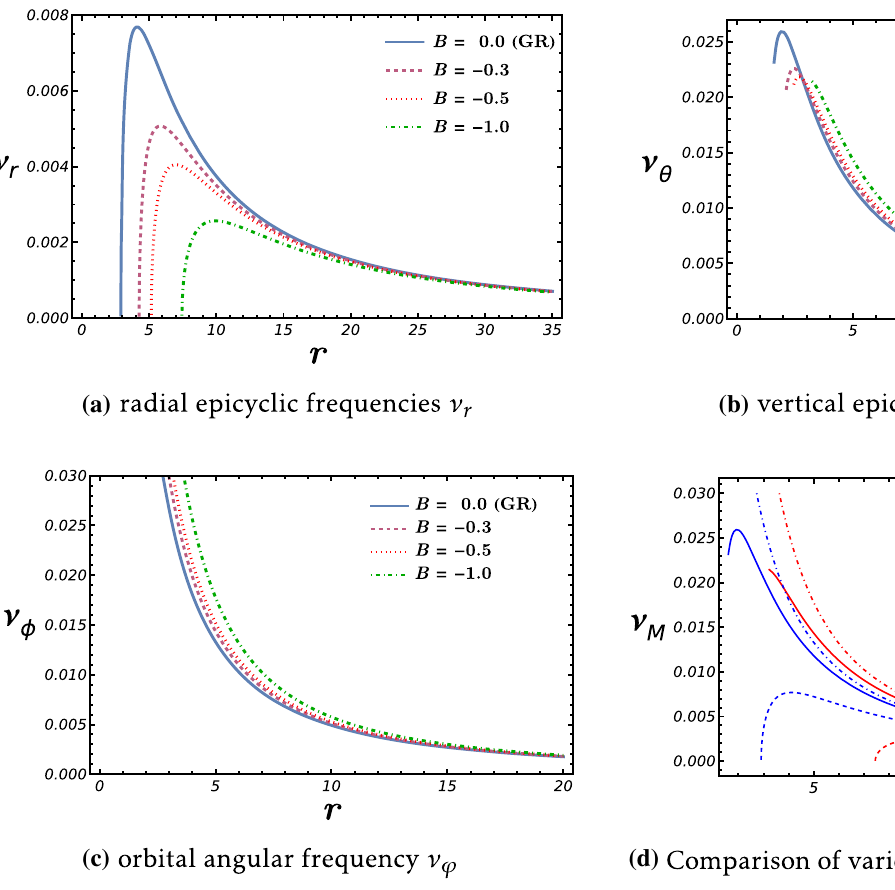
Fig. 6 Profiles of the Keplerian frequency ν ϕ and the epicyclic fre- quencies ν r (radial) and ν θ (vertical) in the modified theory with spin parameter set to a = 0 . 8. The modified gravity parameter B has been